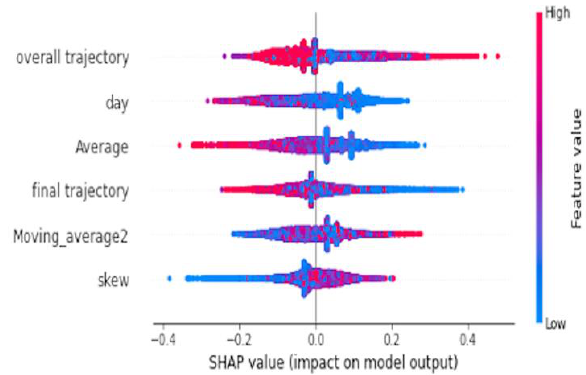
Figure 10. The SHAP Summary Plot for this Prediction Model. Table 10. Input Values for SHAP Force Plot 1.